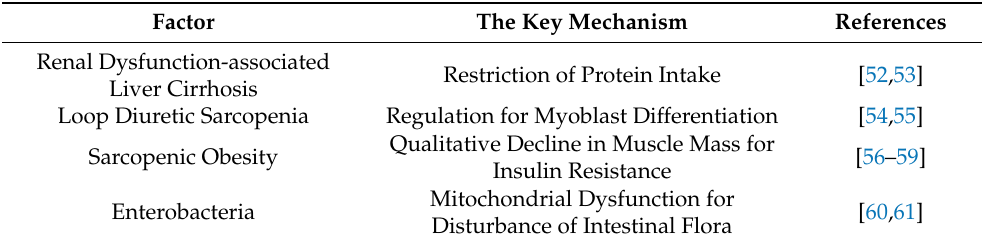
Table 3. Other Effects of Sarcopenia Associated with Liver Cirrhosis. Factor The Key